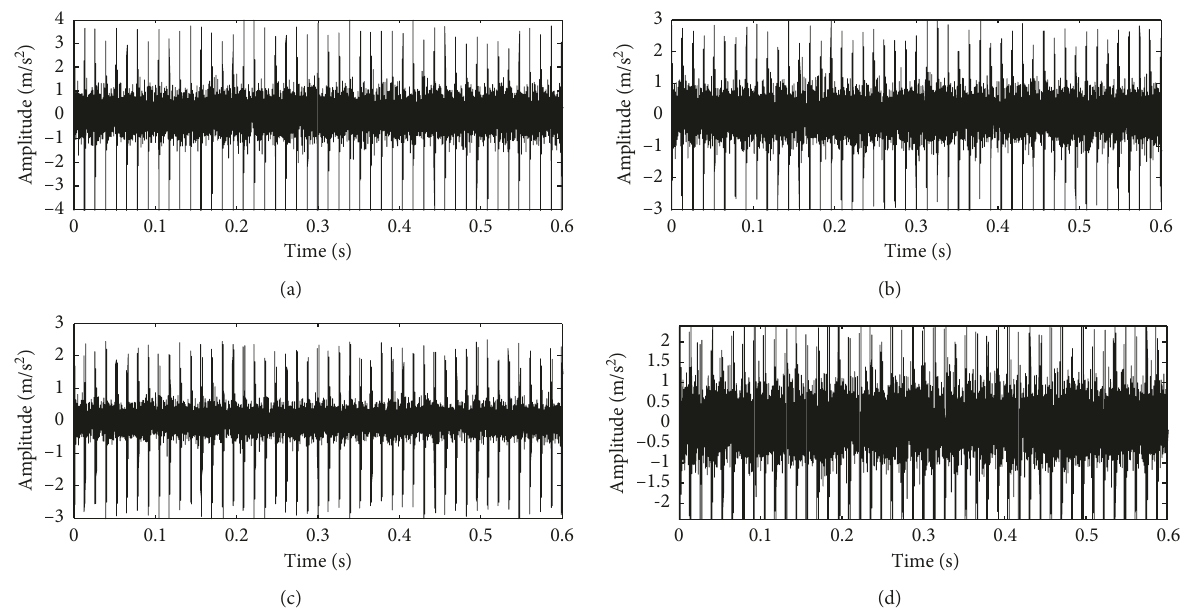
Figure 3: Simulation vibration signal of bearing outer race with different fault sizes. (a) Fault diameter: 0.5mm. (b) Fault diameter: 2mm. (c) Fault diameter: 3.5mm. (d) Fault diameter: